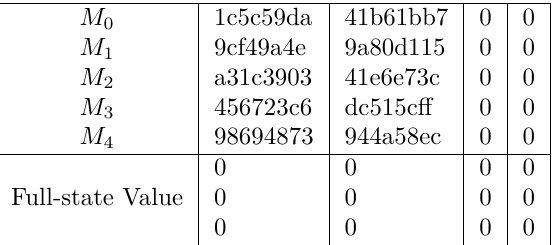
Table 4: A message leading to an all-zero state for 2-round